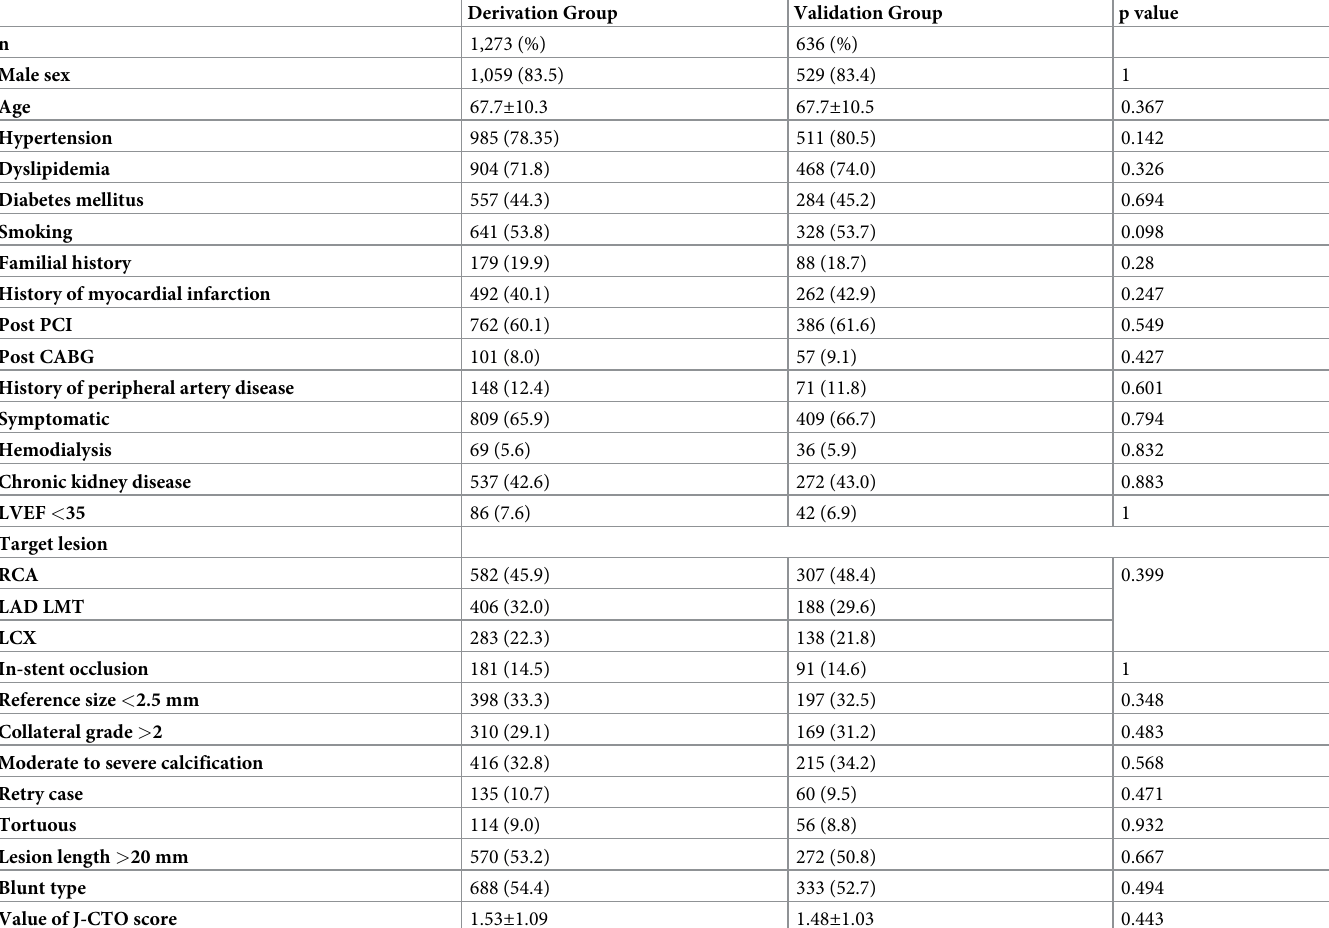
Table 1. Comparison of the participants’ baseline characteristics in the validation and derivation